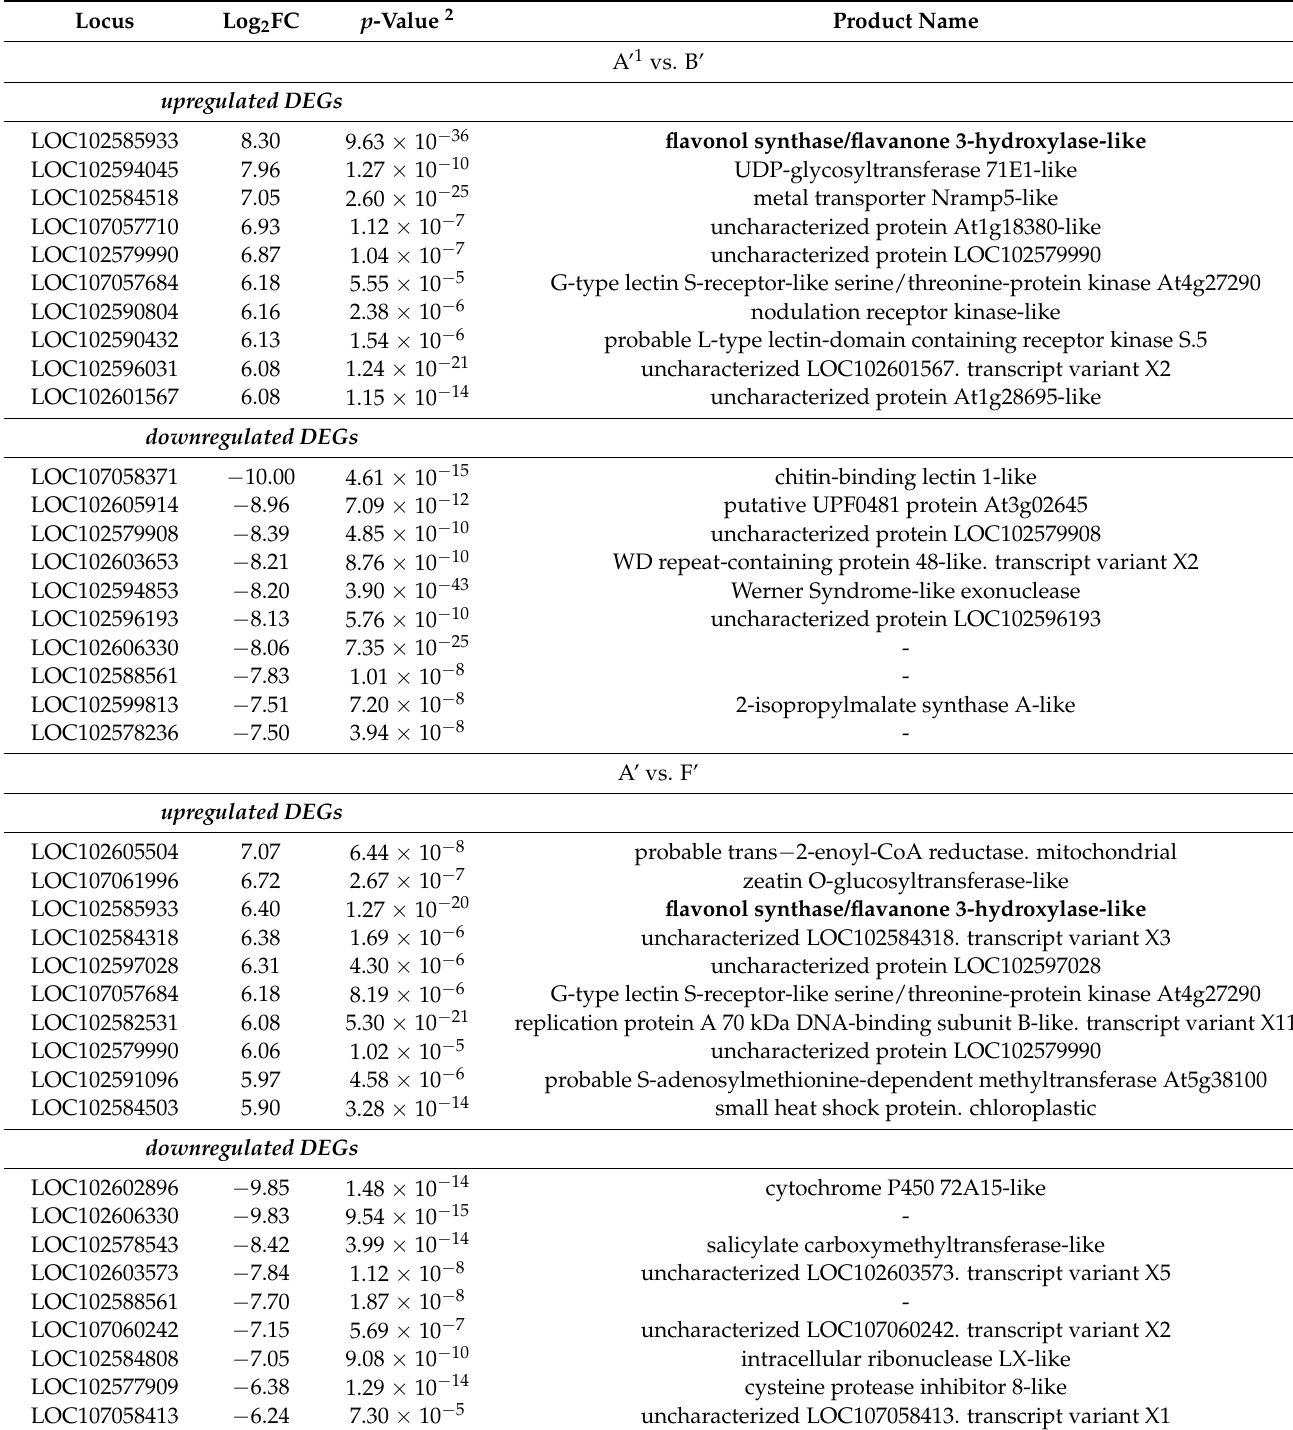
Table 3. The ten most abundant transcripts of upregulated and downregulated genes according to the RNA-seq data following a comparison of bulk samples A’ vs. B’ and A’ vs.